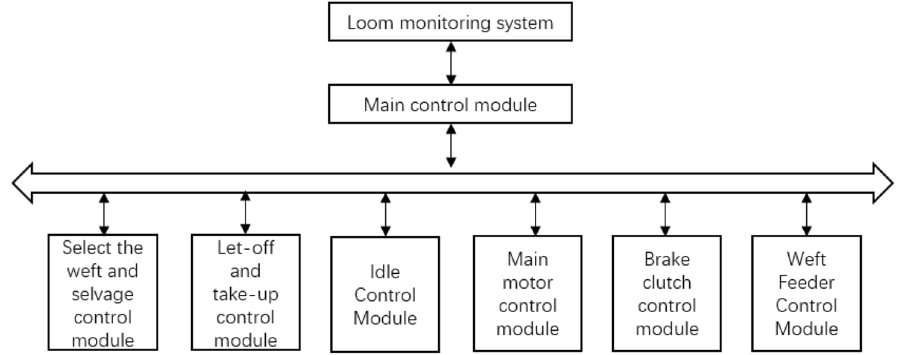
Fig. 1 The overall structure of the loom